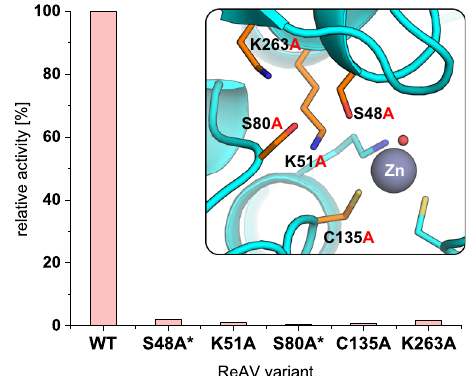
Fig. 5 L -Asparaginase activity of WT ReAV and its mutants, assessed by the Nessler method at pH 8 in the presence of 10 mM L -Asn. In each experiment 0.1 mg of the enzyme was used. After 10 min the optical density at 420 nm (OD 420 ) was measured. The value of OD 420 recorded for WT protein marks full activity (100%). Inset: location of the mutation sites in the putative ReAV active site. Mutants S48A and S80A (marked with an asterisk) might have impaired folding, as indicated by CD spectra. Source data are provided as a Source Data fi